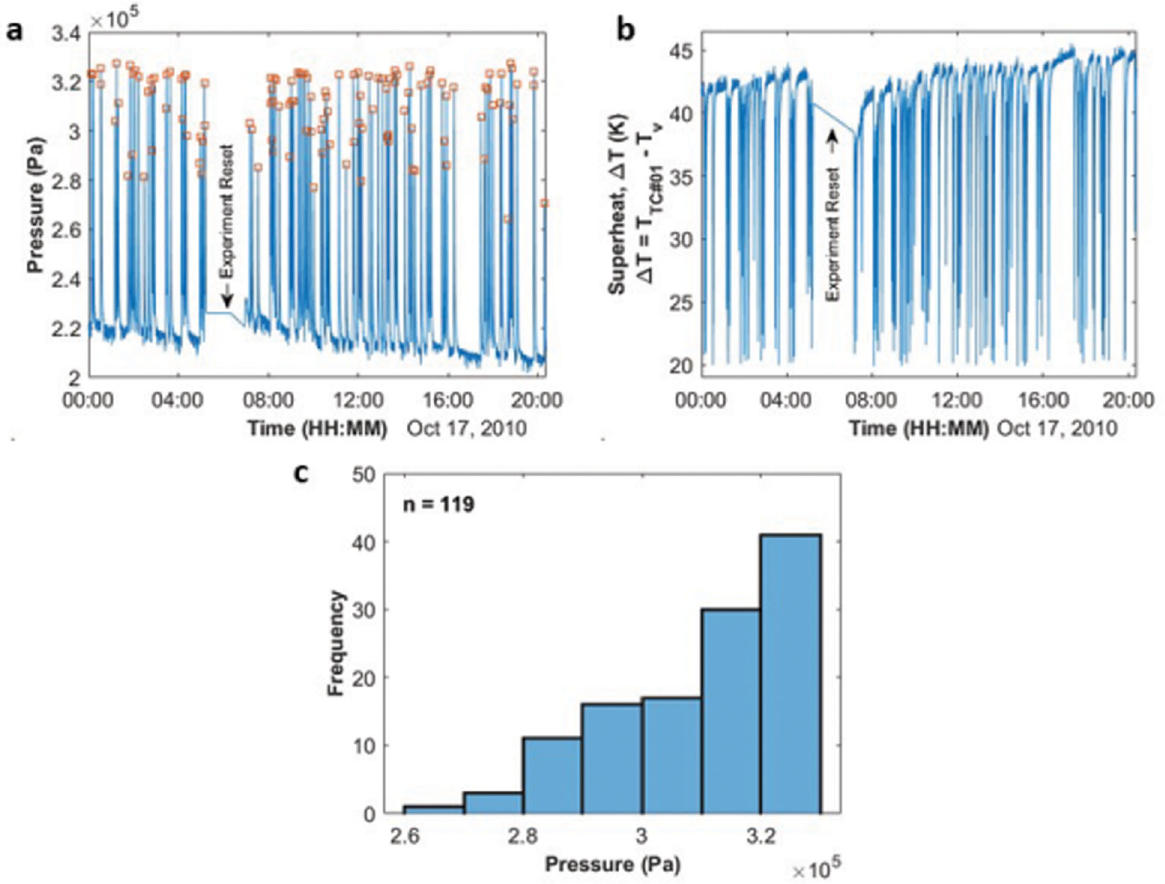
Fig. 2 Pressure data from the nucleation CVB experiment. a Pressure pro fi le across the entire experiment duration (00:00:00 – 20:21:17 Oct 17, 2010). Peak pressure in each cycle is labeled using square dots. b Histogram of all the 119 cycles observed during the entire experiment. With a bin size of 0.1 × 10 5 Pa, there are 7 bins in the diagram. The 7 intervals are (2.6 × 10 5 Pa – 2.7 × 10 5 Pa), (2.7 × 10 5 Pa – 2.8 × 10 5 Pa), (2.8 × 10 5 Pa – 2.9 × 10 5 Pa), (2.9 × 10 5 Pa – 3.0 × 10 5 Pa), (3.0 × 10 5 Pa – 3.1 × 10 5 Pa), (3.1 × 10 5 Pa – 3.2 × 10 5 Pa), and (3.2 × 10 5 Pa – 3.3 × 10 5 Pa). c Superheat ( Δ T ) during the nucleation